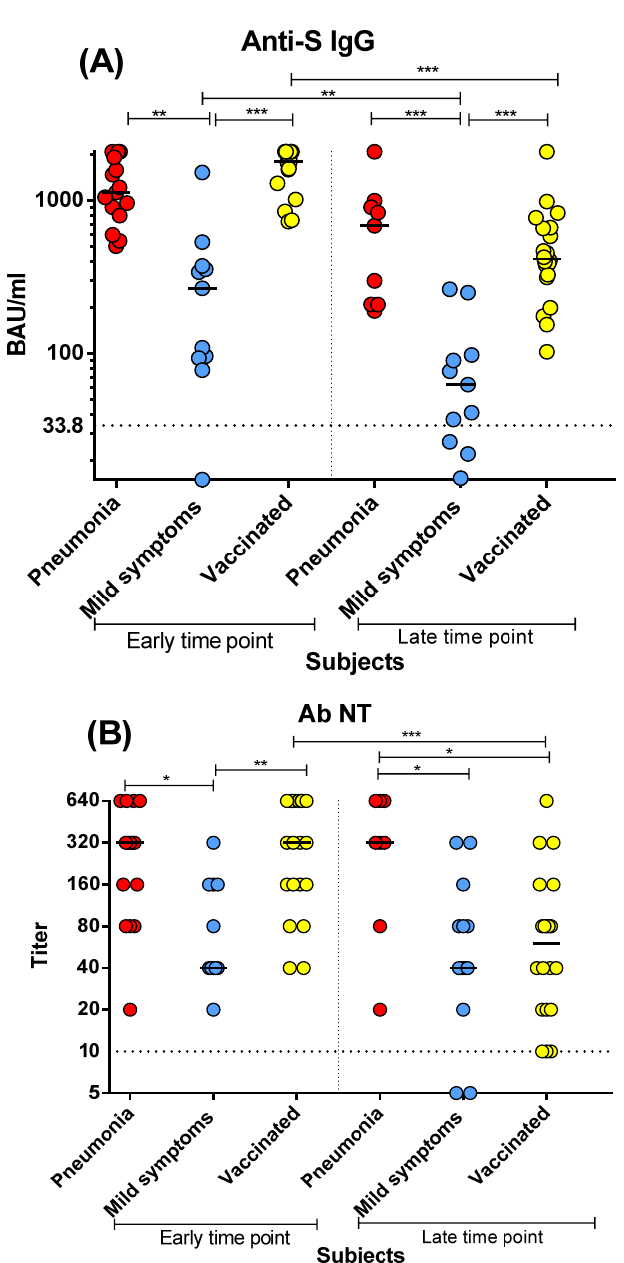
Figure 1. The spike (S)-specific antibody response was compared between post-COVID-19 patients with pneumonia or mild symptoms and vaccinated subjects at early and late time points: ( A ) anti-S IgG; ( B ) neutralising antibodies (Nt Ab). Early time point: patients with pneumonia, median 59 (range 45–90) days after infection; patients with mild symptoms, 48 (24–90) days after infection; vaccinated subjects three weeks after two vaccine doses. Late time point: patients with pneumonia, median 212 (range 186–400) days after infection; patients with mild symptoms, 193 (150–306) days after infection; vaccinated subjects six months after two vaccine doses. * p < 0.05, ** p < 0.01, *** p < 0.001.